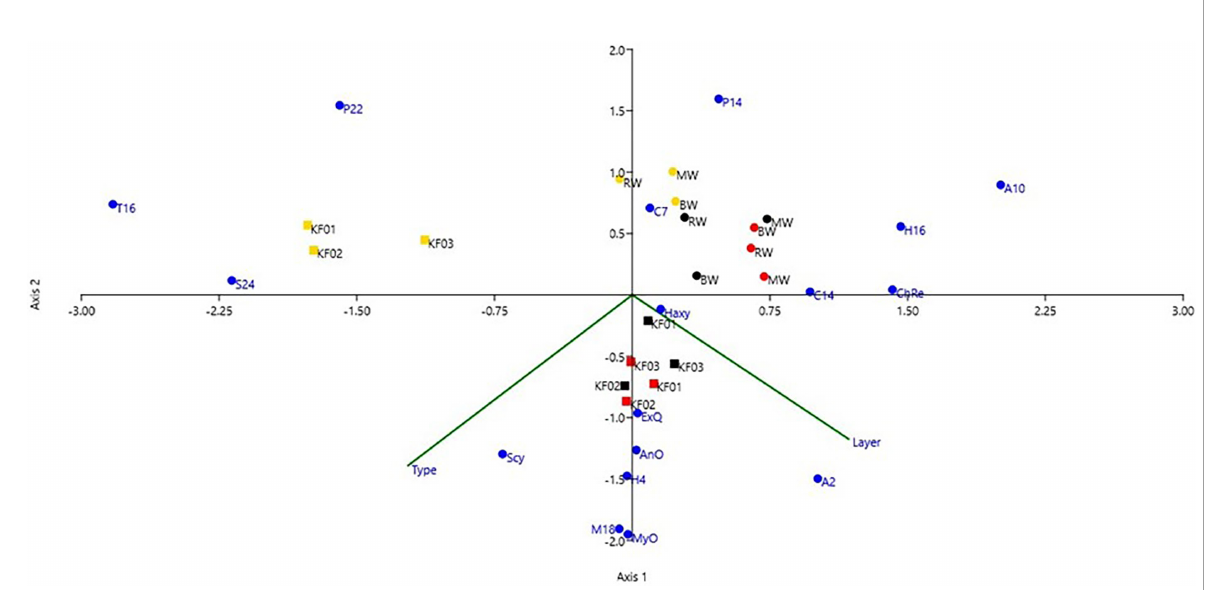
FIGURE 4 Species-conditional CCA triplot based on a canonical correspondence analysis of the coccinellid and environmental data recorded at rural sites in Cambridgeshire and Suffolk. Environmental vectors are ampli fi ed by a factor of two. Axis 1 explained 99.3% of the variation in the taxon-environmental structure and axis 2 explained 0.7% of the variation (Eigenvalues were 0.3505 and 0.0024 respectively); Type = coniferous sites (KF01, KF02, KF03 = Kings Forest site 1, 2 and 3) and deciduous sites (BW = Brampton Wood, MW = Monk ’ s Wood, RW = Raveley Wood); Layer = tree, shrub and herb layer (coloured in red, black and gold respectively); coniferous sites are indicated by fi lled squares, deciduous sites by fi lled dots and coccinellid species by blue dots; coccinellid species = (A2, Adalia bipunctata ; A10, Adalia decempunctata ; AnO, Anatis ocellata ; C7, Coccinella septempunctata ; C14, Calvia quattuordecimguttata ; ChRe, Chilocorus renipustulatus ; ExQ, Exochomus quadripustulatus ; H4, Harmonia quadripunctata ; H16, Halyzia sedecimguttata ; Hax, Harmonia axyridis ; M18, Myrrha octodecimguttata ; MyO, Myzia oblongoguttata ; P14, Propylea quatuordecimpunctata ; P22, Psyllobora vigintiduopunctata ; S24, Subcoccinella vigintiquatuorpunctata ; Scy, Scymnus suturalis ; T16, Tytthaspis sedecimpunctata